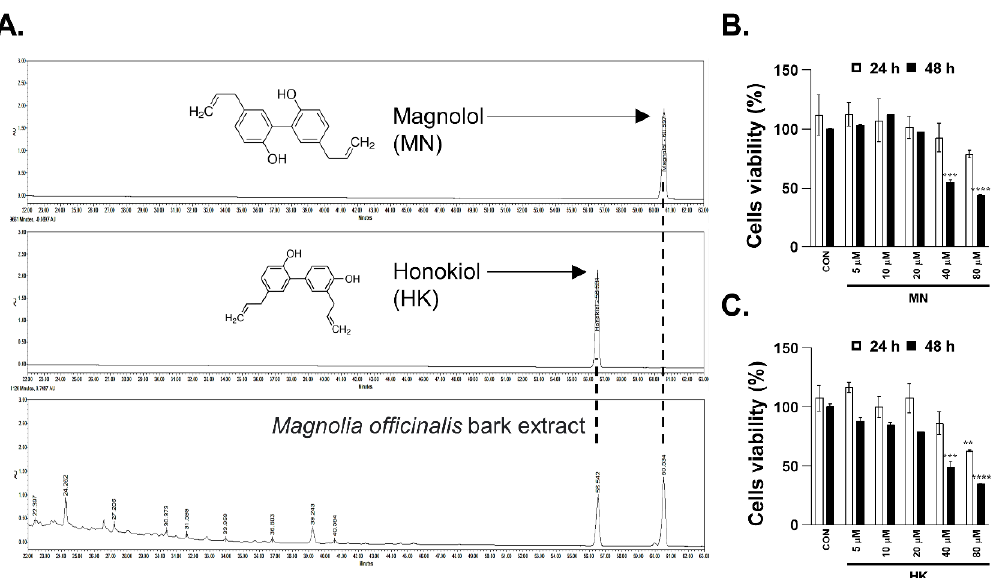
Figure 5. Identification of MBE compounds and cell viability assays. ( A ) HPLC profiles of MBE components. Chemical structures of two standards (Glc = β -D-glucopyranosyl, Rha = α -L-rhamnopyranosyl) and HPLC chromatograms of two standards (1 mg/mL) and a sample extract at a concentration of 20 mg/mL are shown. ( B – C ) Viability tests of HT29 cells treated with various concentrations of MN ( B ) and HK ( C ) for 24 h and 48 h. ** p < 0.01, *** p < 0.001, and **** p < 0.0001 (data were analyzed using an ANOVA).